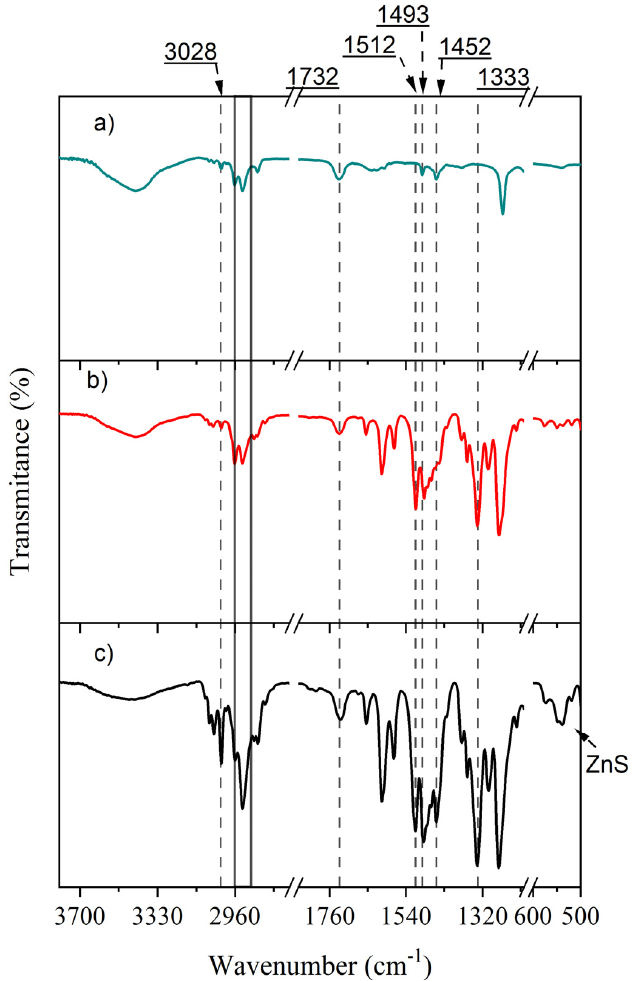
Figure 3. FT-IR spectrum of ( a ) PS- b -PMMA, ( b ) PS- b -PMMA- SP and ( c ) PS- b -PMMA- SP -ZnS functionalized block copolymer. The x -axis in the spectrum appears bracket for the sake of simplicity.